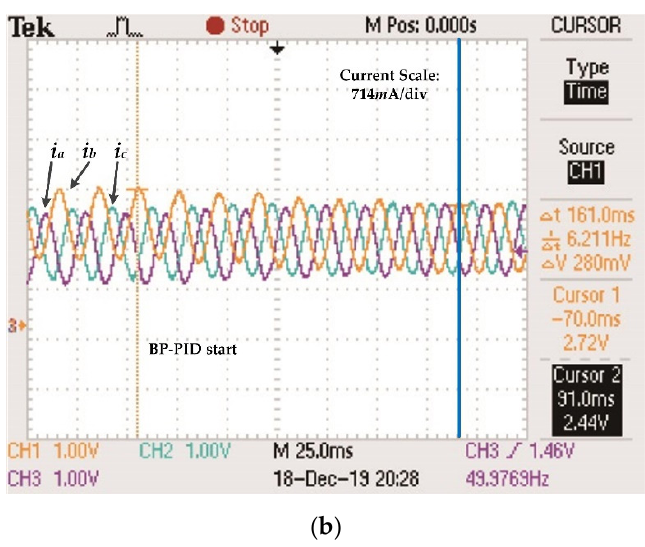
Figure 9. Waveforms of the grid current. ( a ) Transient response of the grid current based on the GA-BP-PID scheme. ( b ) Transient response of the grid current based on the BP-PID scheme.